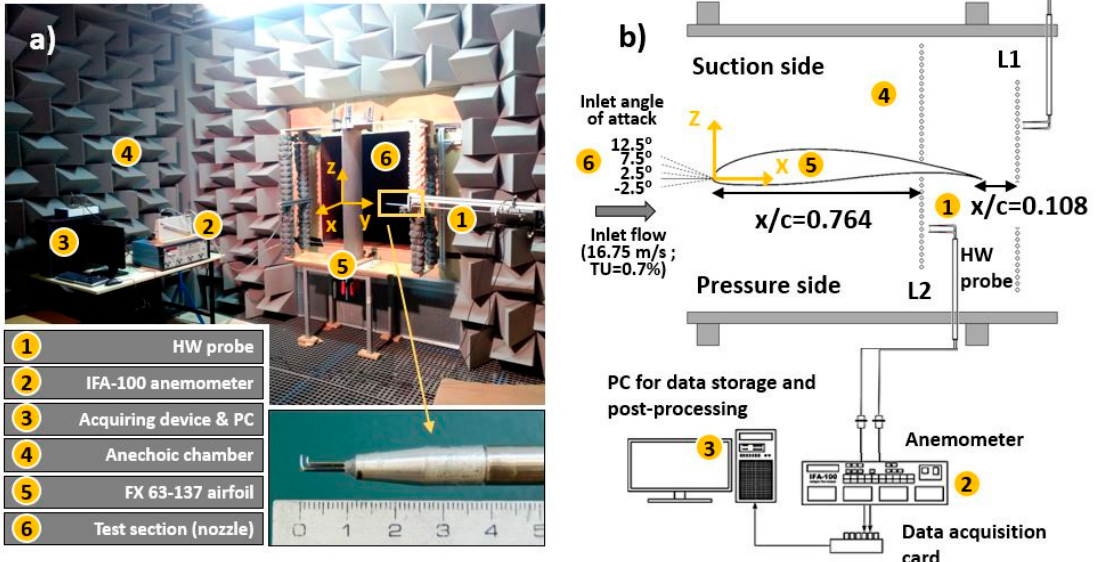
Figure 5. ( a ) Experimental setup for hot-wire measurements. ( b ) Sketch of the measuring